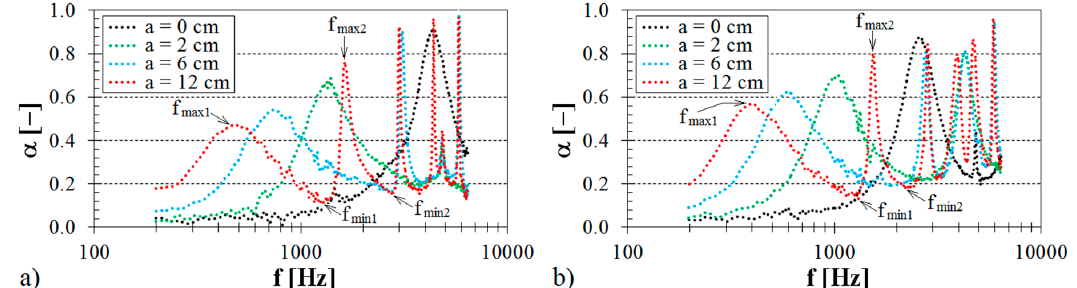
Figure 5. Influence of the sample thickness on the frequency dependencies of the sound absorption coefficient for the tested ABS samples: ( a ) Cartesian structure, volume ratio V r = 44%, air space size a = 12 cm; ( b ) Starlit structure, volume ratio V r = 70%, air space size a = 0 cm.